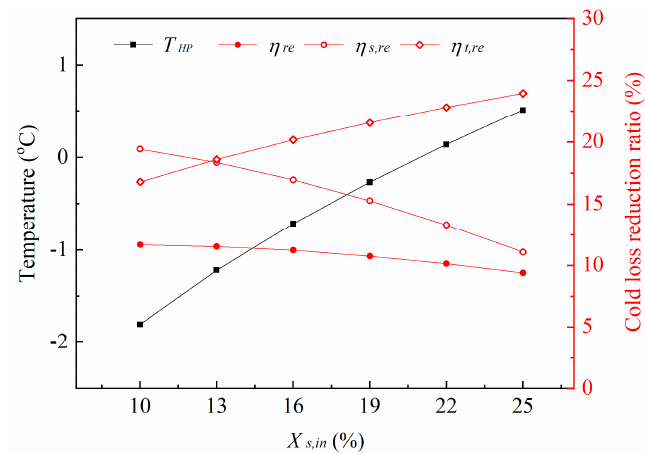
s,in and X t,in together (shown in Figures